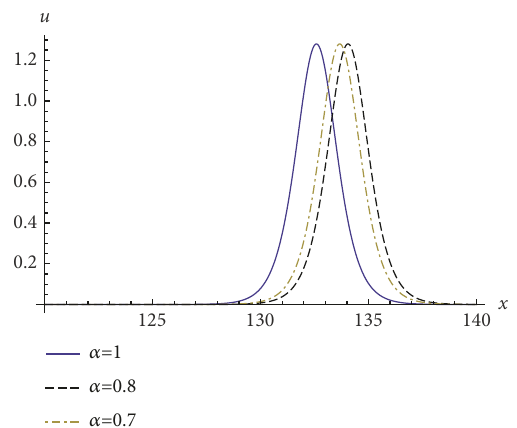
Figure 3: Fractional one-solitons determined by solution (43) at time 𝑡 = 80 .